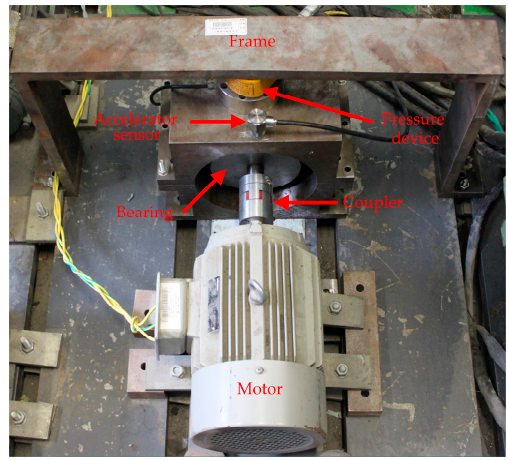
Figure 4. The physical test platform.